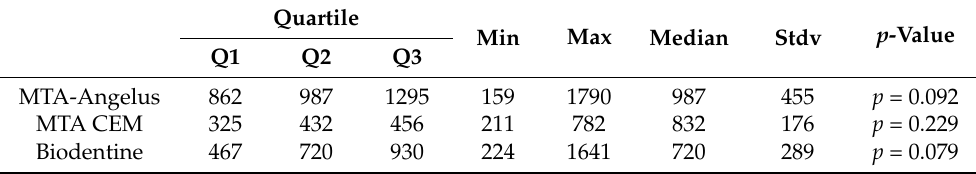
Table 1. Bacterial Penetration depth (in um) in the different